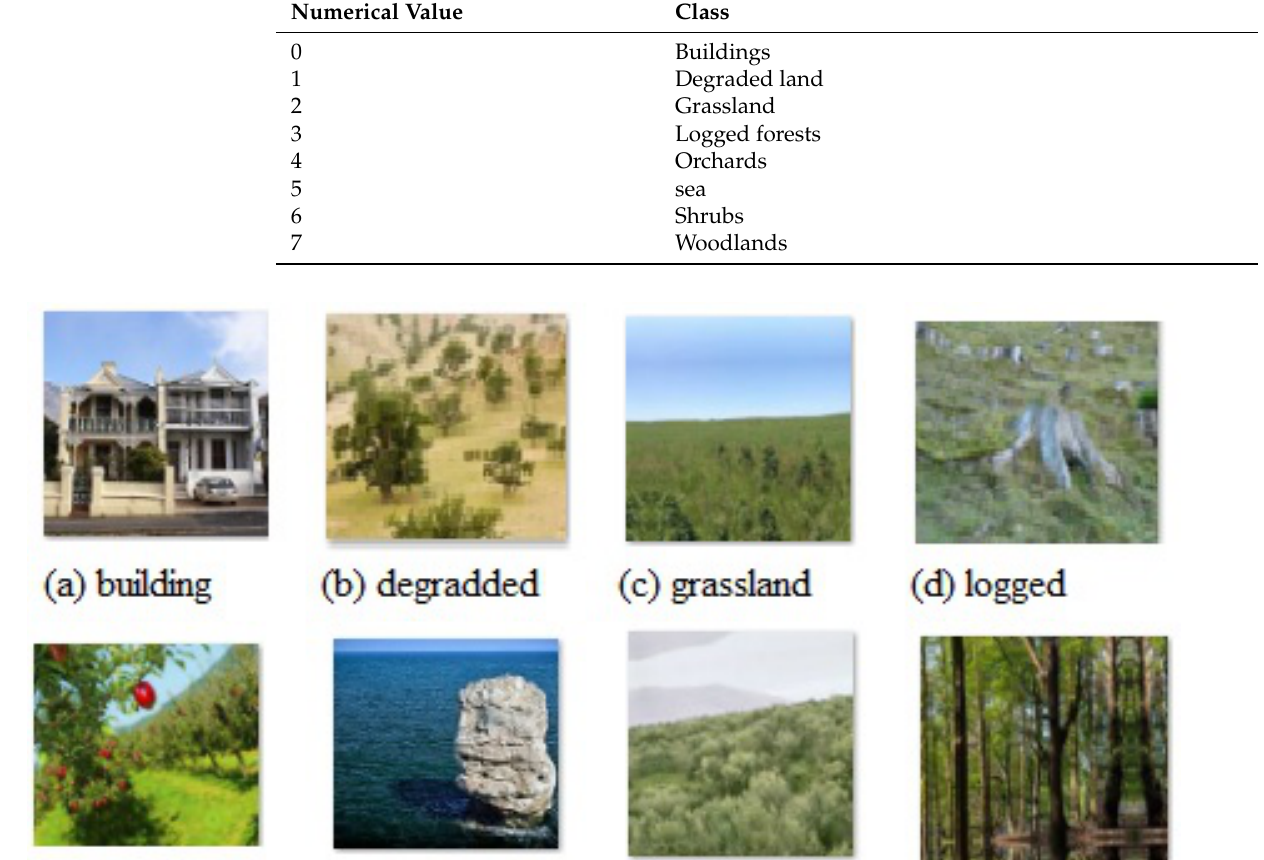
Table 3. Class labels.